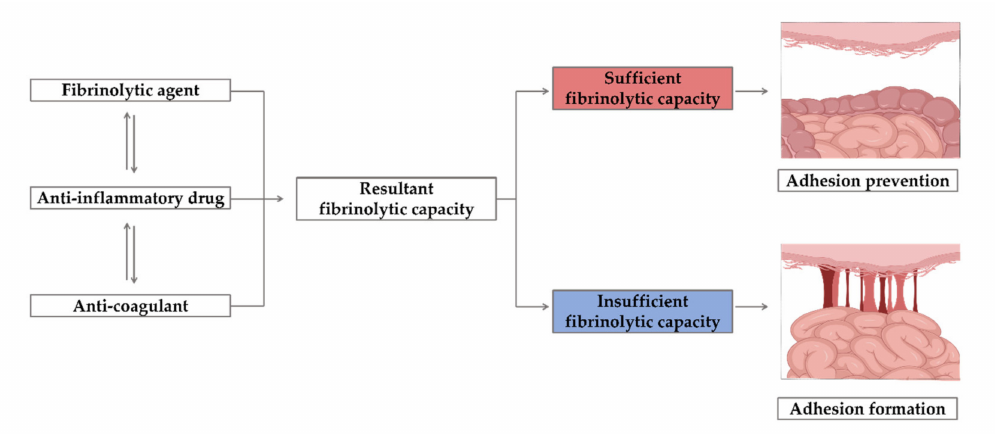
Figure 8. The e ff ects of fibrinolytic agents, anti-inflammatory drugs, and anti-coagulants as anti-adhesion